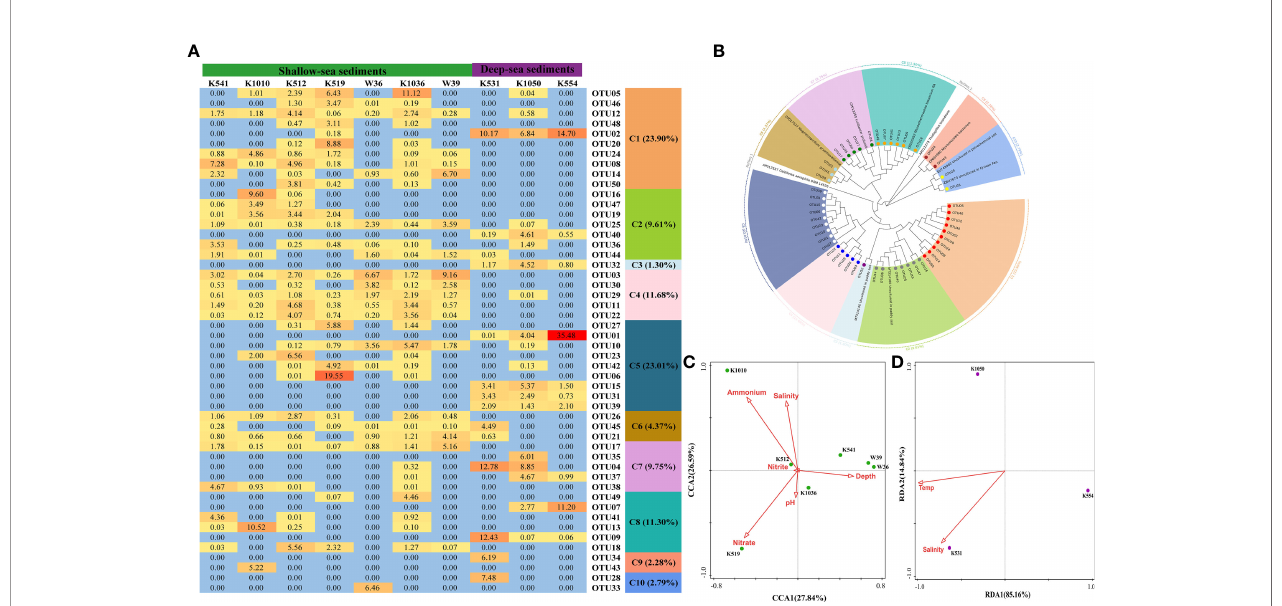
FIGURE 5 | Microbial characteristics of the nos Z II gene in surface sediments of the northern SCS. (A) The heat map of dominant OTUs (Top 50 OTUs). (B) Neighbor-joining phylogenetic tree of dominant OTUs (Top 50 OTUs) and the reference sequences from Genbank (bootstrap 1000). (C) The canonical correspondence analysis (CCA) for the nos Z II gene from shallow-sea surface sediments. (D) The redundancy analysis (RDA) for the nos Z II gene from deep-sea surface